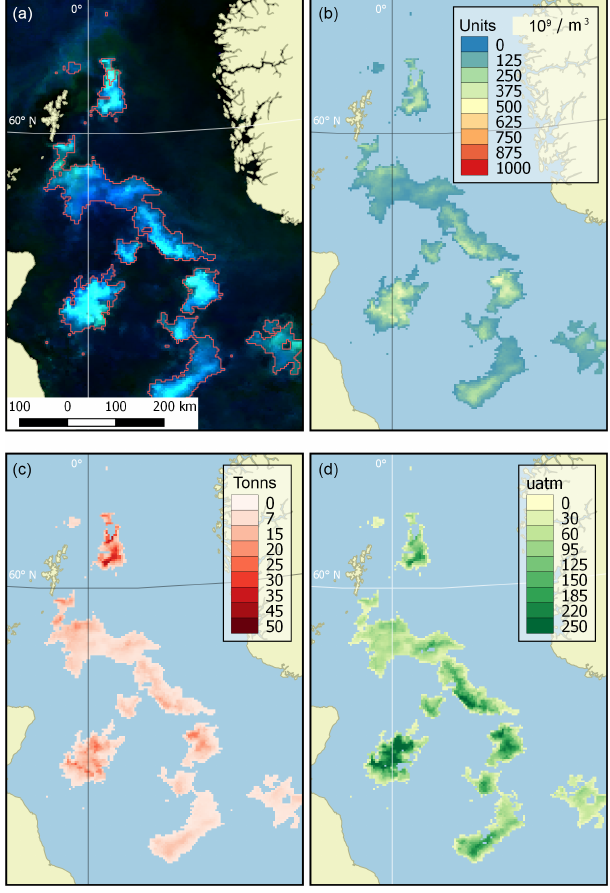
Figure 2. Example of dataset products (the North Sea, 9 June 2016). (a) Source OC CCI RGB imagery with the bloom mask con- toured in red, (b) coccolith concentration (10 9 m − 3 ), (c) content of particulate inorganic carbon (tonnes) and (d) an increase in CO 2 partial pressure in water